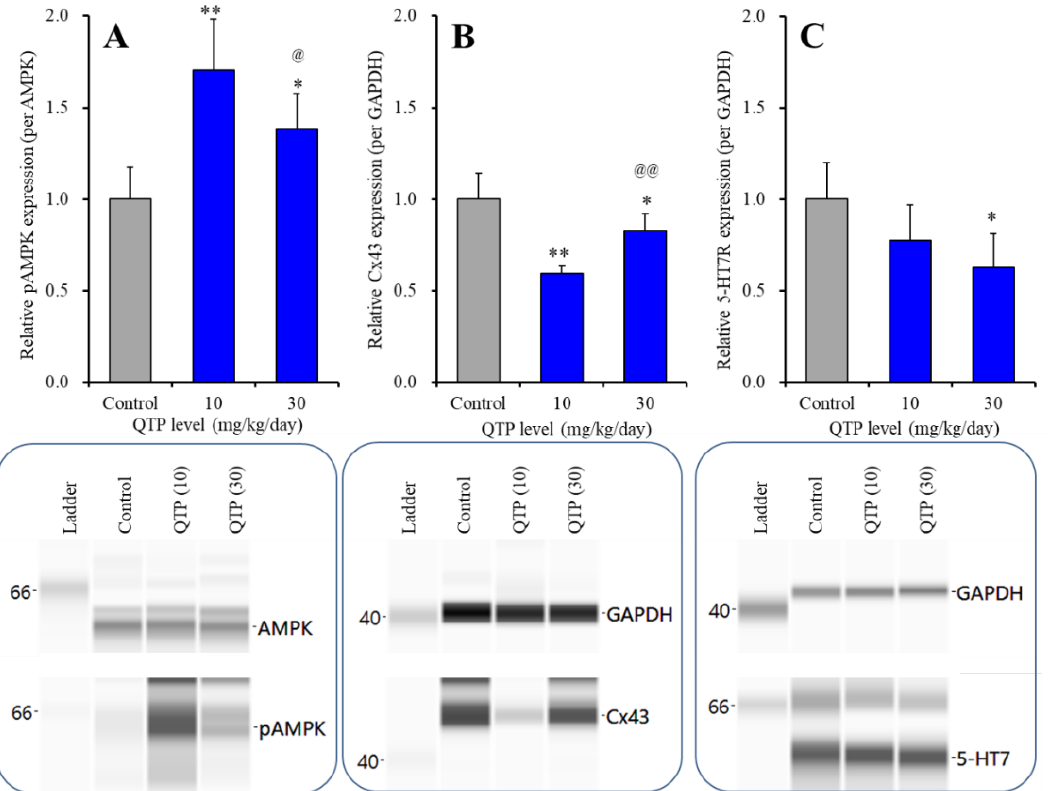
Figure 7. Dose-dependent effects of systemically subchronic administration (7 days) of QTP on protein expression of pAMPK ( A ), Cx43 ( B ) in the cytosol fraction and 5-HT7R ( C ) in the plasma membrane fraction of rat hypothalamus. In upper side histograms, ordinate: mean ± SD (n = 6) of the relative protein level of pAMPK per AMPK, Cx43 and 5-HT7R per GAPDH. Abscissa: QTP dose (mg/kg/day). * p < 0.05, ** p < 0.01: relative to control (QTP free), @ p < 0.05, @@ p < 0.01: relative to 10 mg/kg/day QTP by one-way ANOVA with Tukey’s post-hoc test. Lower side panels indicate their pseudo-gel images using capillary immunoblotting.